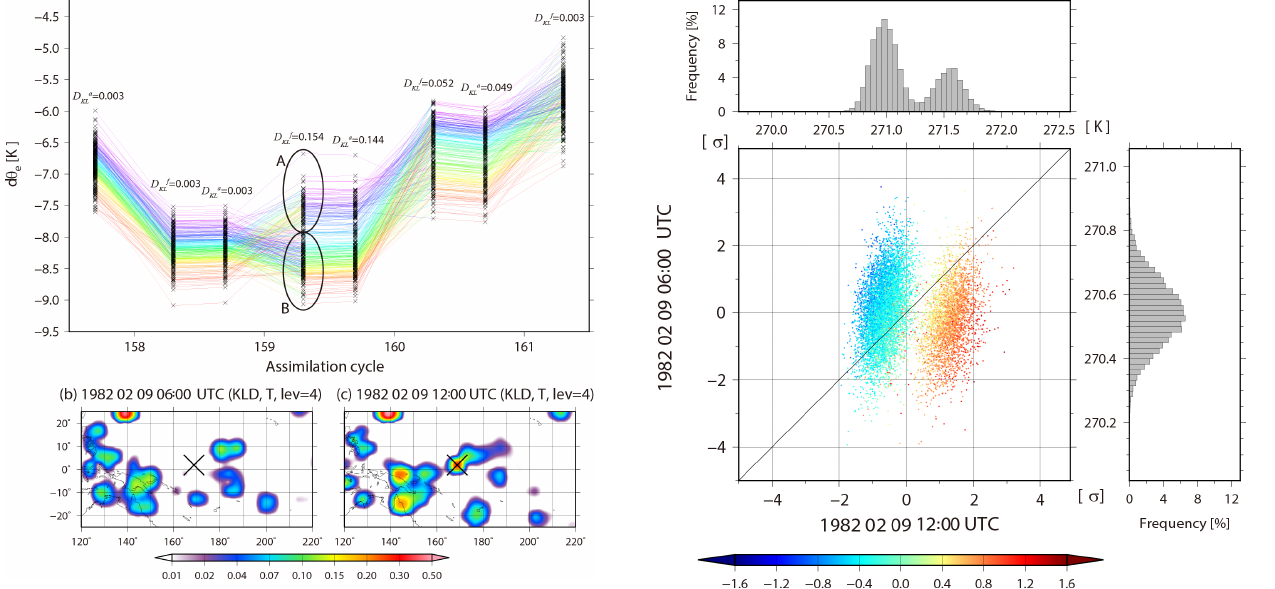
Figure 11. Scatter diagram of 06:00UTC versus 12:00UTC on 9 February for the background temperature at the fourth model level ( ∼ 500hPa) at 1.9 ◦ N, 168.7 ◦ E. The colors show d θ (cid:48) e = ( d θ e 12 : 00UTC − d θ e 06 : 00UTC ) − (cid:0) d θ e 12 : 00UTC − d θ e 06 : 00UTC (cid:1) The histograms in the right and upper panels show the background temperature at the same grid point.